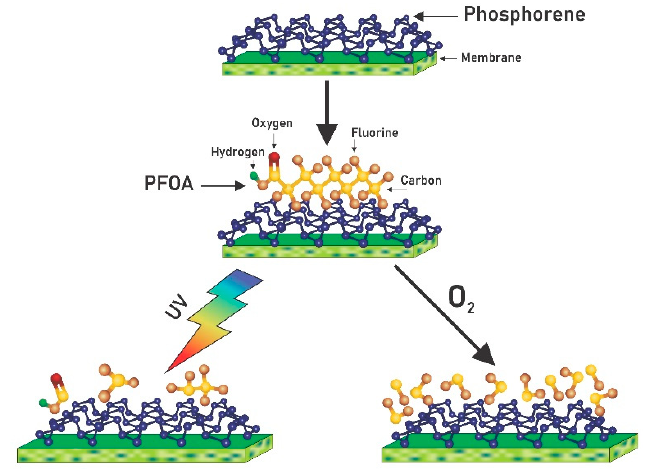
Figure 1. Schematics of experimental process showing the filtration of perfluorooctanoic acid (PFOA) on phosphorene membranes followed by either treatment using UV irradiation or liquid aerobic oxidation.